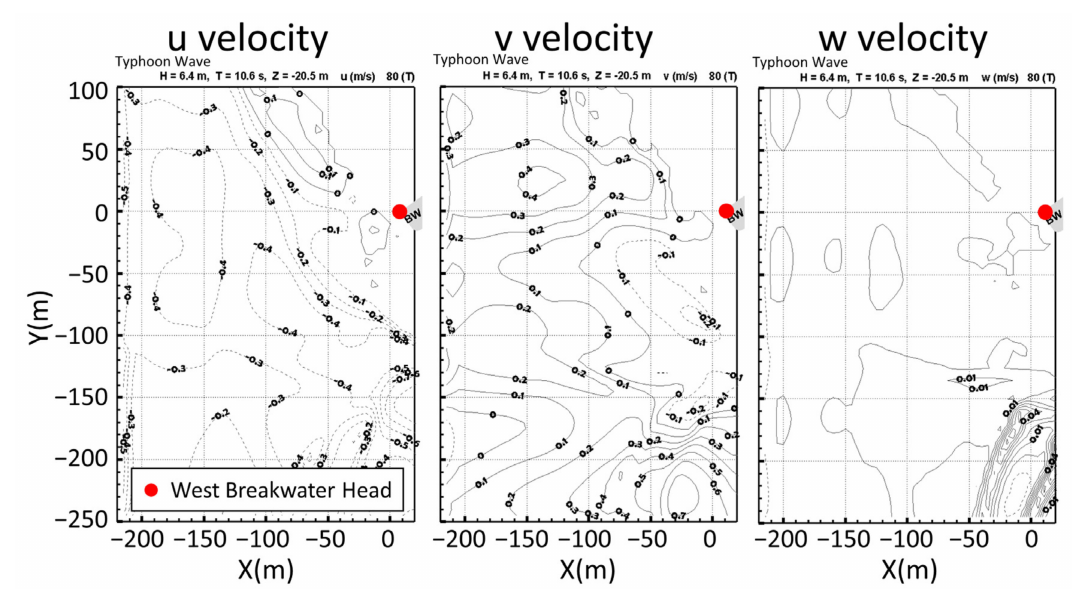
Figure 32. The bottom u, v, w velocity